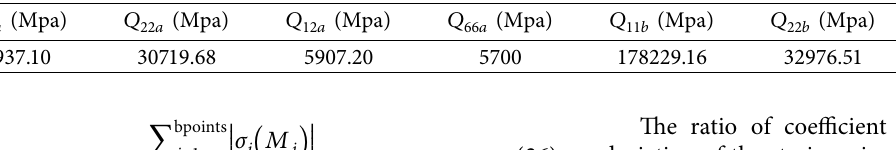
Table 2: Reference constitutive parameters of orthotropic